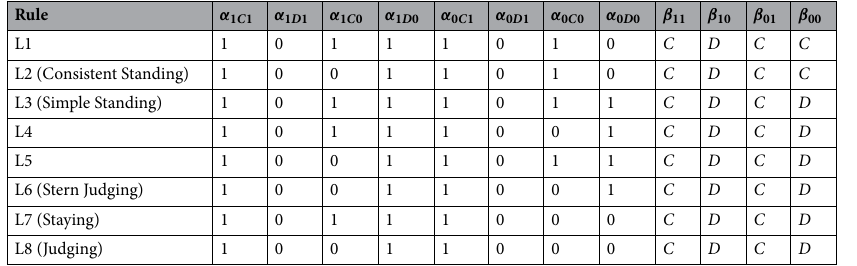
Table 1. Leading eight. Cooperation and defection are denoted as C and D , respectively, and a player’s reputation is either good (1) or bad (0). By α uXv , we mean the reputation assigned to a player who did X ∈ { C , D } with reputation u to another player with reputation v . The behavioural rule β uv prescribes what a player should do between C and D when he or she has reputation u and the co-player has reputation v . We note that L1 has been known as Contrite Tit-for-Tat in the context of direct reciprocity 27–30